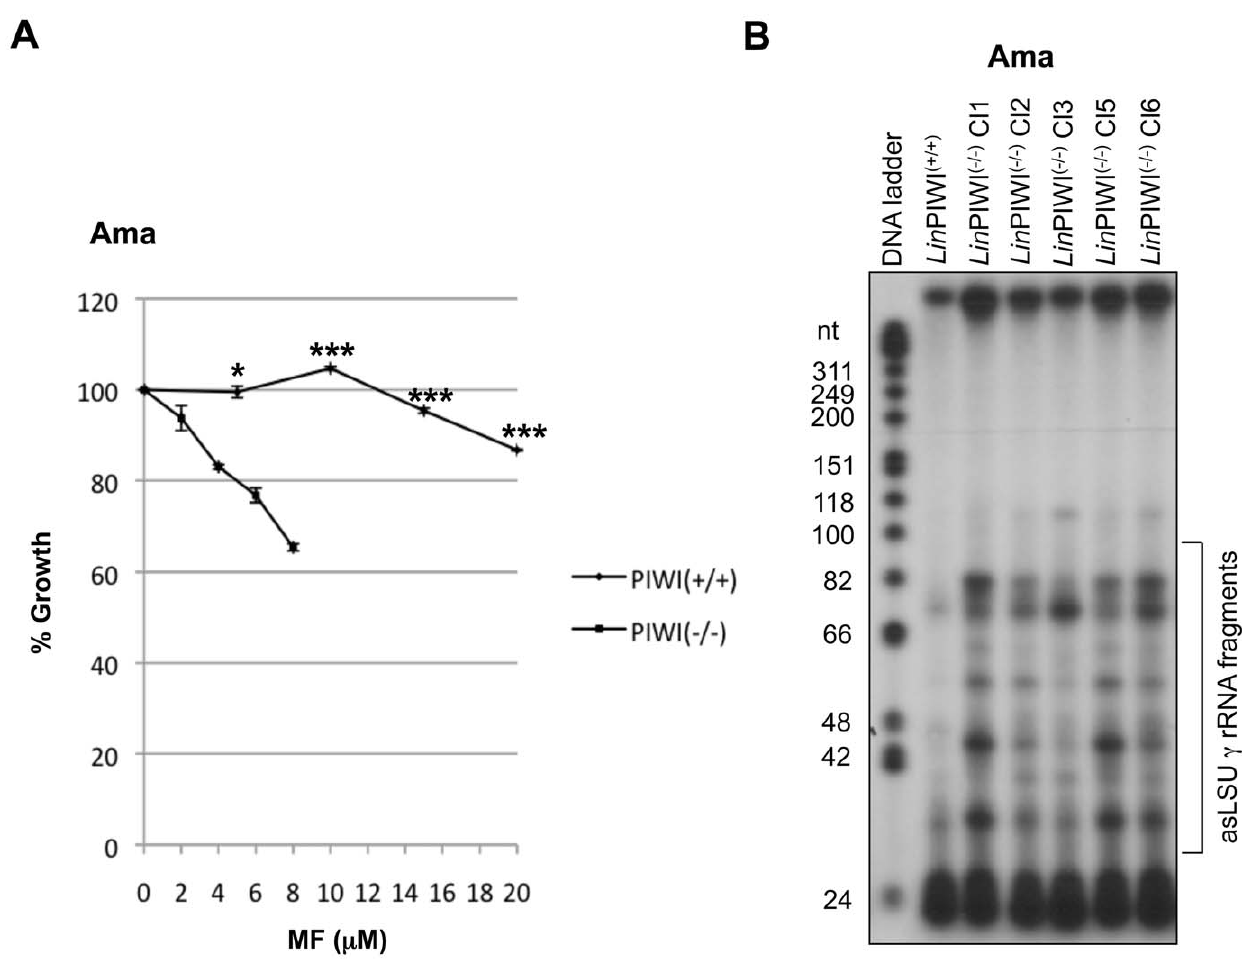
Figure 6. Leishmania amastigotes lacking PIWI are more sensitive to apoptosis-like cell death inducing agents. (A) Lin PIWI ( 2 / 2 ) was shown to be highly sensitive to miltefosine (MF). Equal number of L. infantum axenic amastigotes (Ama) of wild type and Lin PIWI ( 2 / 2 ) mutant strains were treated with various concentrations of MF for a period of 8 hrs. Drug sensitivity was evaluated by measuring the OD at 600 nm in a 96 well plates. The results are expressed as mean 6 SD of biological triplicates and the experiments were conducted twice with similar results. The comparison of growth percentage between L. infantum WT treated with 0, 5, 10, 15, 20 m M of MF and Lin PIWI ( 2 / 2 ) treated with 0, 2, 4, 6 and 8 m M of MF, respectively ( Lin PIWI ( 2 / 2 ) is much more sensitive to MF than WT) was analyzed by t-test (non parametric) using GraphPad Prism (version 3.03) software. Significant differences between WT and Lin PIWI ( 2 / 2 ) are indicated (*, P , 0.05; ***, P , 0.001). (B) Primer extension analysis of L. infantum wild type ( Lin PIWI ( + / + ) ) and five independent clones (Cl 1–3, Cl 5 and Cl 6) of Lin PIWI ( 2 / 2 ) null mutant grown as axenic amastigotes using a forward primer corresponding to nucleotides 101–118 of the sLSU c rRNA to detect antisense (as) LSU c rRNA fragmentation.